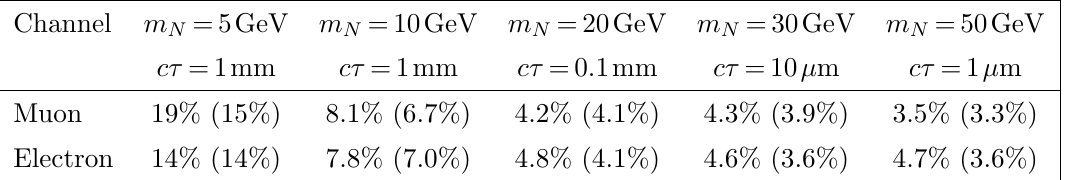
Table 5. Prompt-trilepton relative uncertainty of signal yields for muon and electron channels after applying the selection criteria. Uncertainties correspond to those obtained after the (cid:12)t. Un- certainties associated to the limited number of events in the MC samples and in the CRs for the multi-fake background estimation are shown in